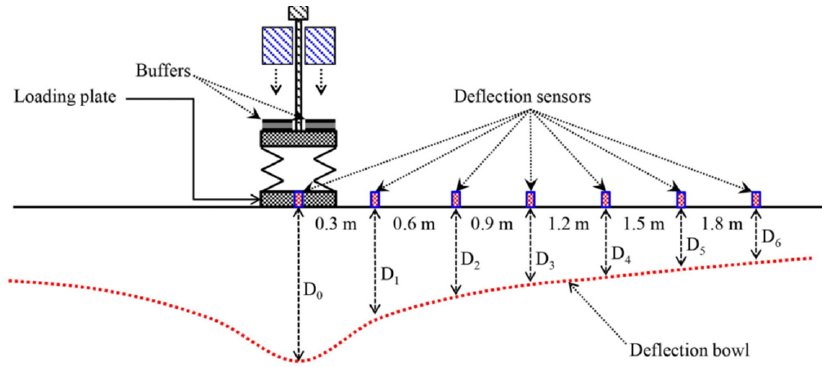
Figure 10. Deflection sensor setting.